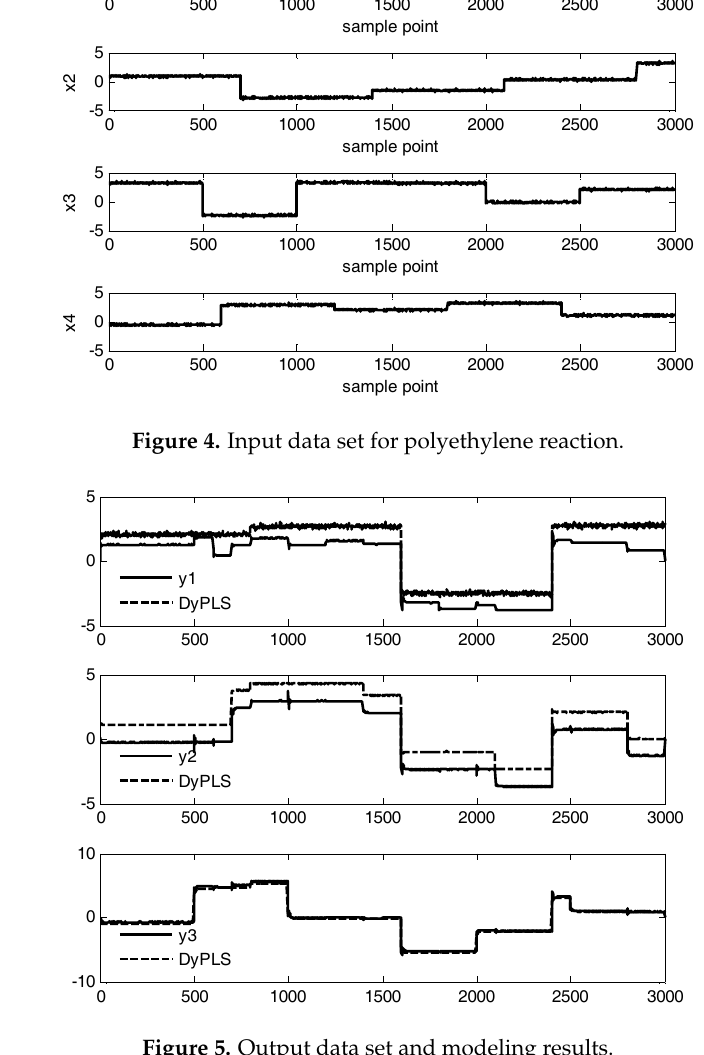
Figure 6. Control results of conventional model predictive control (MPC) in dynamic PLS.